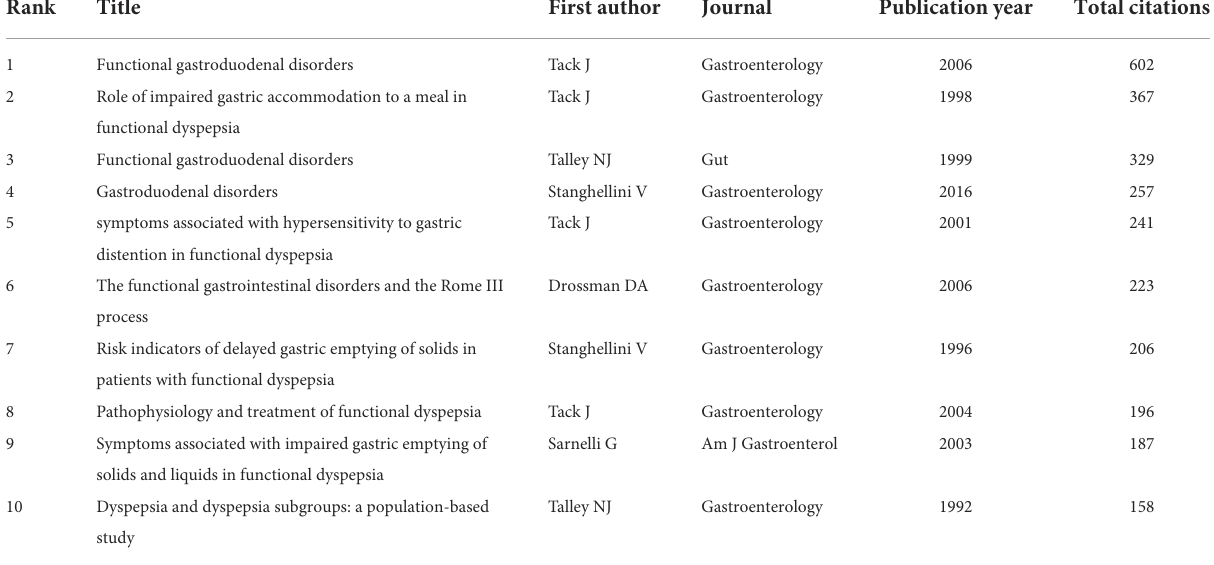
TABLE 6 Top 10 co-citation of cited reference about